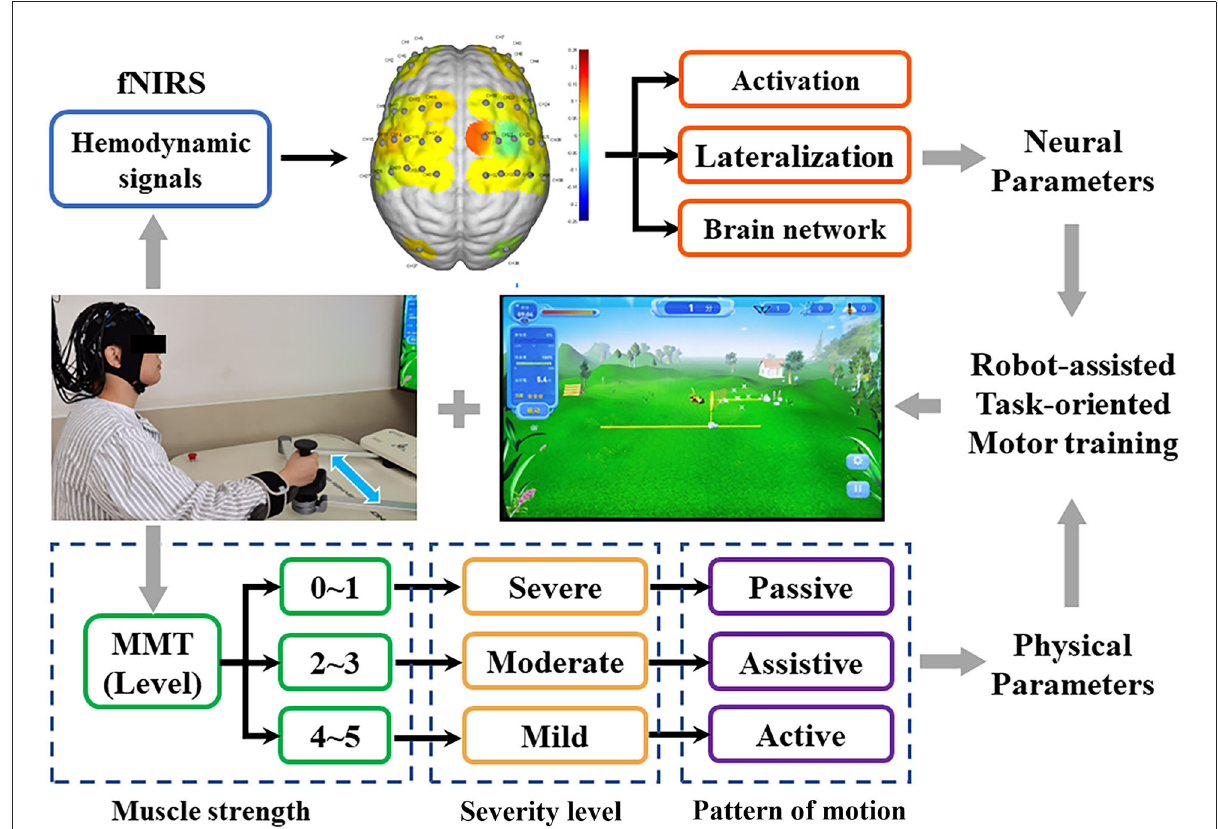
FIGURE1 Experimental protocol. The fNIRS technique was used to detect the real-time hemodynamic signal of patients with three different degrees of UL dysfunction during motor training. Activation, lateralization, and brain network as neural parameters were used to evaluate fNIRS